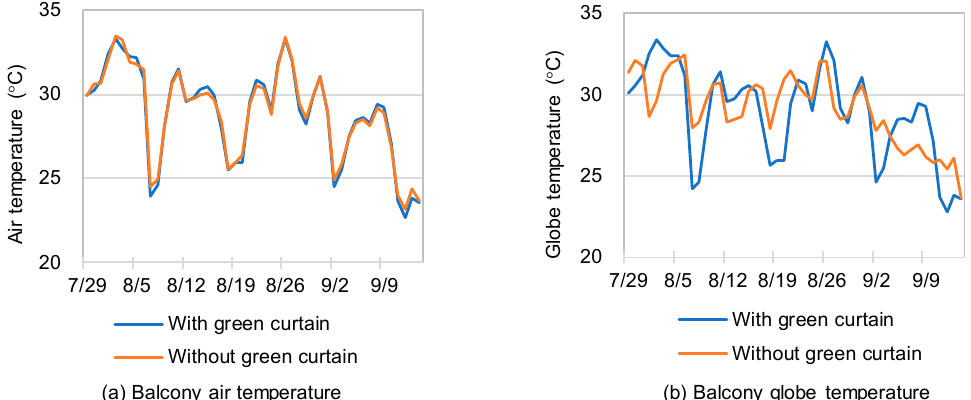
Figure 11. Globe temperature and air temperature in the balcony with green curtain and without the green curtain.